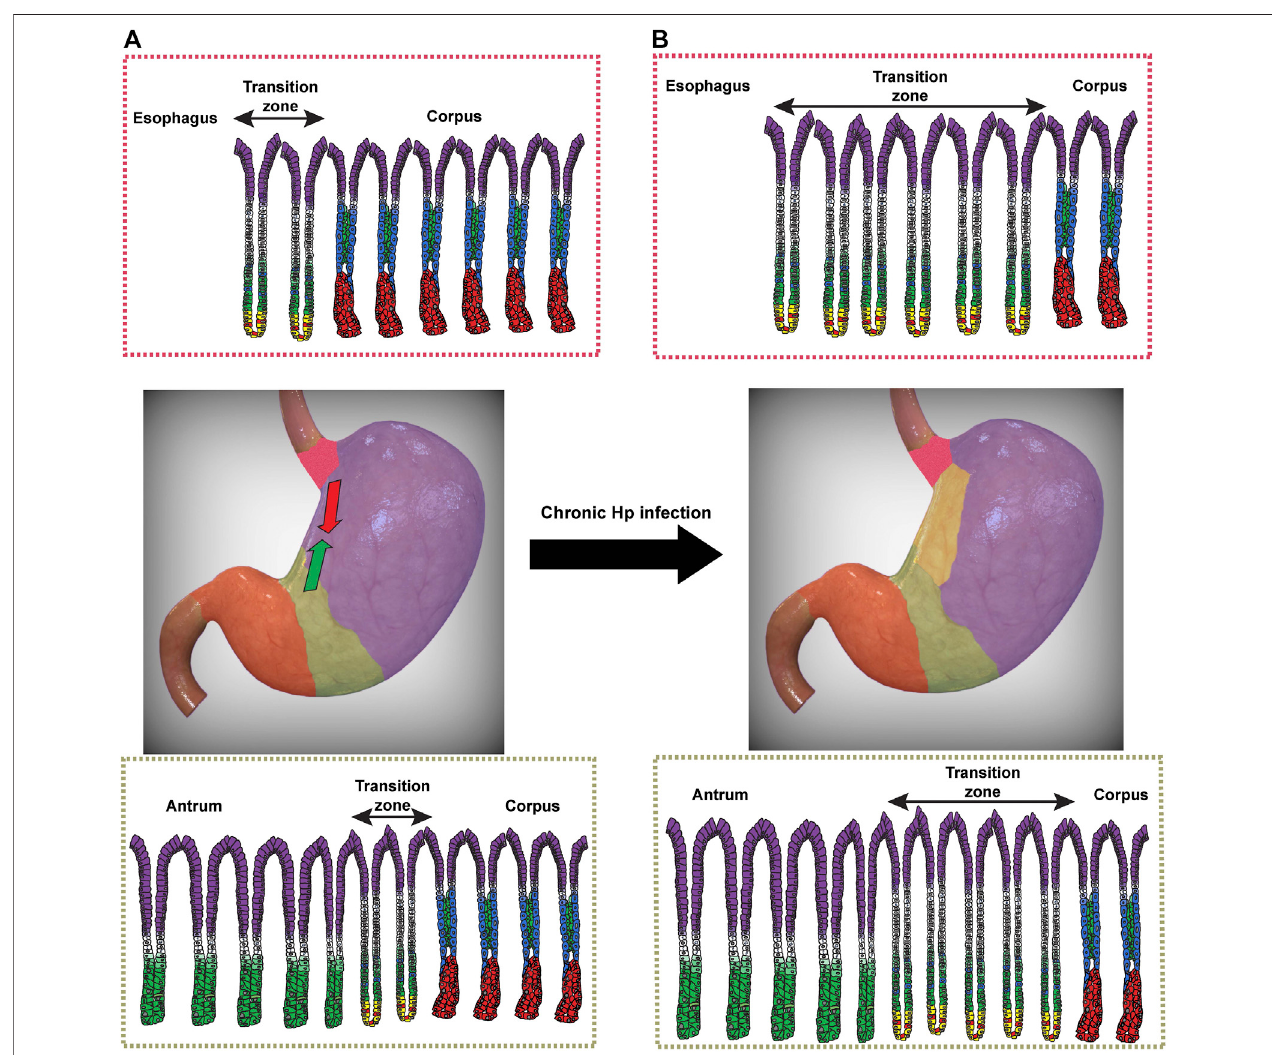
FIGURE 2 | Expansion of transition zones during chronic Helicobacter pylori (Hp) infection. (A) Transition zones exist between the distal esophagus and glandular corpus(red)andbetweenthecorpusandantrum(green).Athomeostasis,corpusglandsarecharacterizedbyacid-secretingparietalcells(blue)liningtheglandaxisand zymogenic chief cells at thegland base (red). Pit cells (purple), mucous neck cells(green), and theproliferativeisthmalstemcells (white) are also shown.Athomeostasis, the cardia (top) contains a small number of glands within the transition zone (double-sided arrow) that show a mixed mucous/oxyntic morphology, with a relative paucity of parietal cells and an expansion of SPEM cells (yellow) with hybrid features of chief cells and mucous neck cells. A similar transition zone exists between the glands of the corpus and antrum (bottom) . (B) Following chronic Hp infection, the number of glands with mixed mucous/oxyntic morphology increases, and the transition zones expand bi-directionally to converge along the lesser curvature. The human stomach images were modi fi ed from a stock image purchased from turboquid.com.